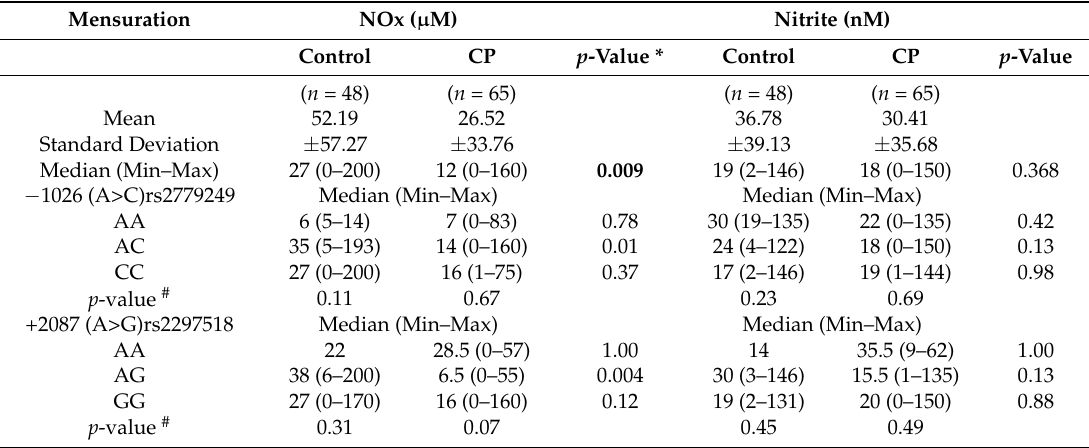
Table 4. Salivary NOx and Nitrite concentrations comparisons between Control and CP